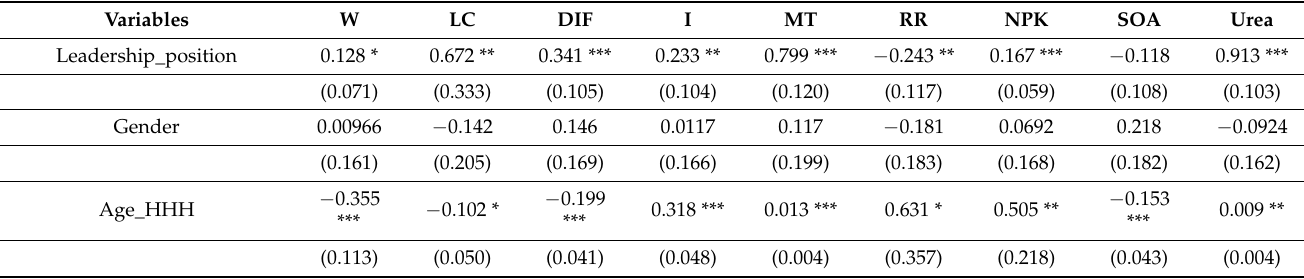
Table A1. First-stage estimations of determinants of household’s investment in long and short-term land improving